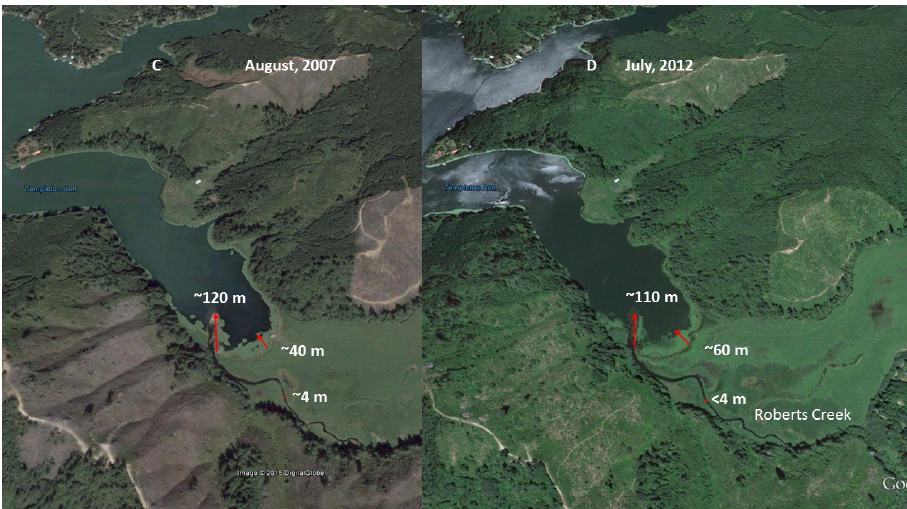
Figure 9. US Geological Survey color aerial images of Tenmile Lake, Templeton Arm, and Roberts Creek. ( C ): The August 2007, aerial image shows the Roberts Creek channel is incised, and the delta is expanding. ( D ): The July 2012, aerial image shows the Roberts Creek channel is unchanged, and the delta has been reduced by approximately 10 m from the August 2007 image. The August 2007 image also shows increased clear cuts on the slopes in three areas south of (below) the lake. Source: Images obtained from Google Earth. Note: Red arrows show the extent of delta growth.